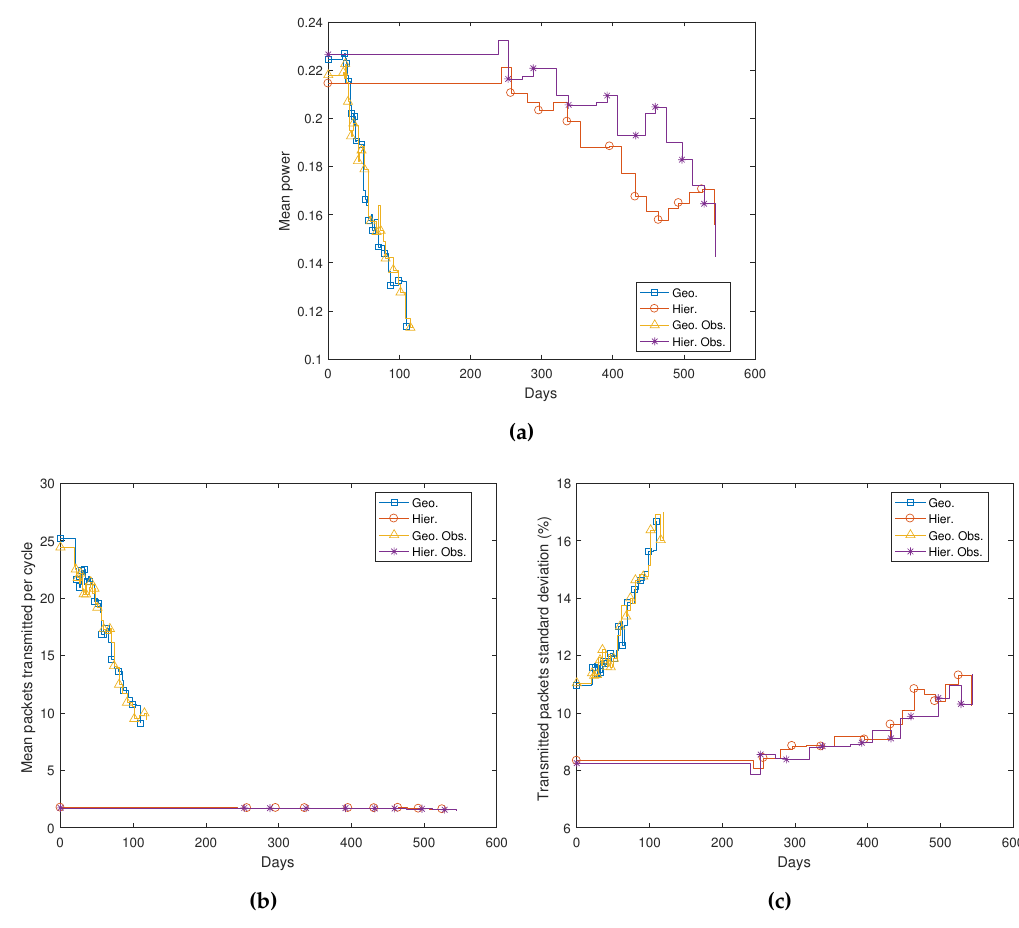
Figure 16. Power evolution in time: ( a ) mean power in the network; ( b ) mean transmitted packets; ( c ) transmitted packets’ standard